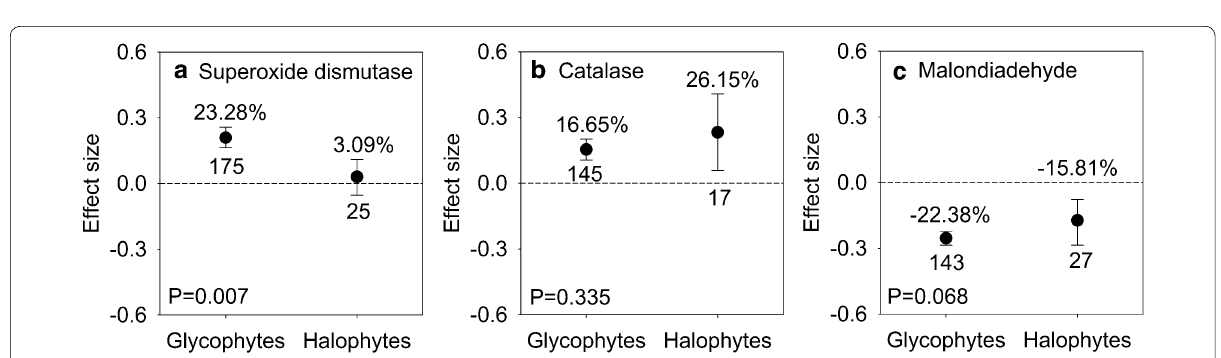
Fig. 4 Responses to salt stress of superoxide dismutase ( a ), catalase ( b ) and malondialdehyde ( c ) in mycorrhizal halophytes and mycorrhizal glycophytes. Error bars represent 95% confidence intervals (CIs). Back-transformed effect sizes are shown above the bars. The numbers of studies are shown under the bars. Inoculation effects were considered significant when the 95% CIs did not overlap with zero. The P values for each panel reflect the significant differences between halophytes and